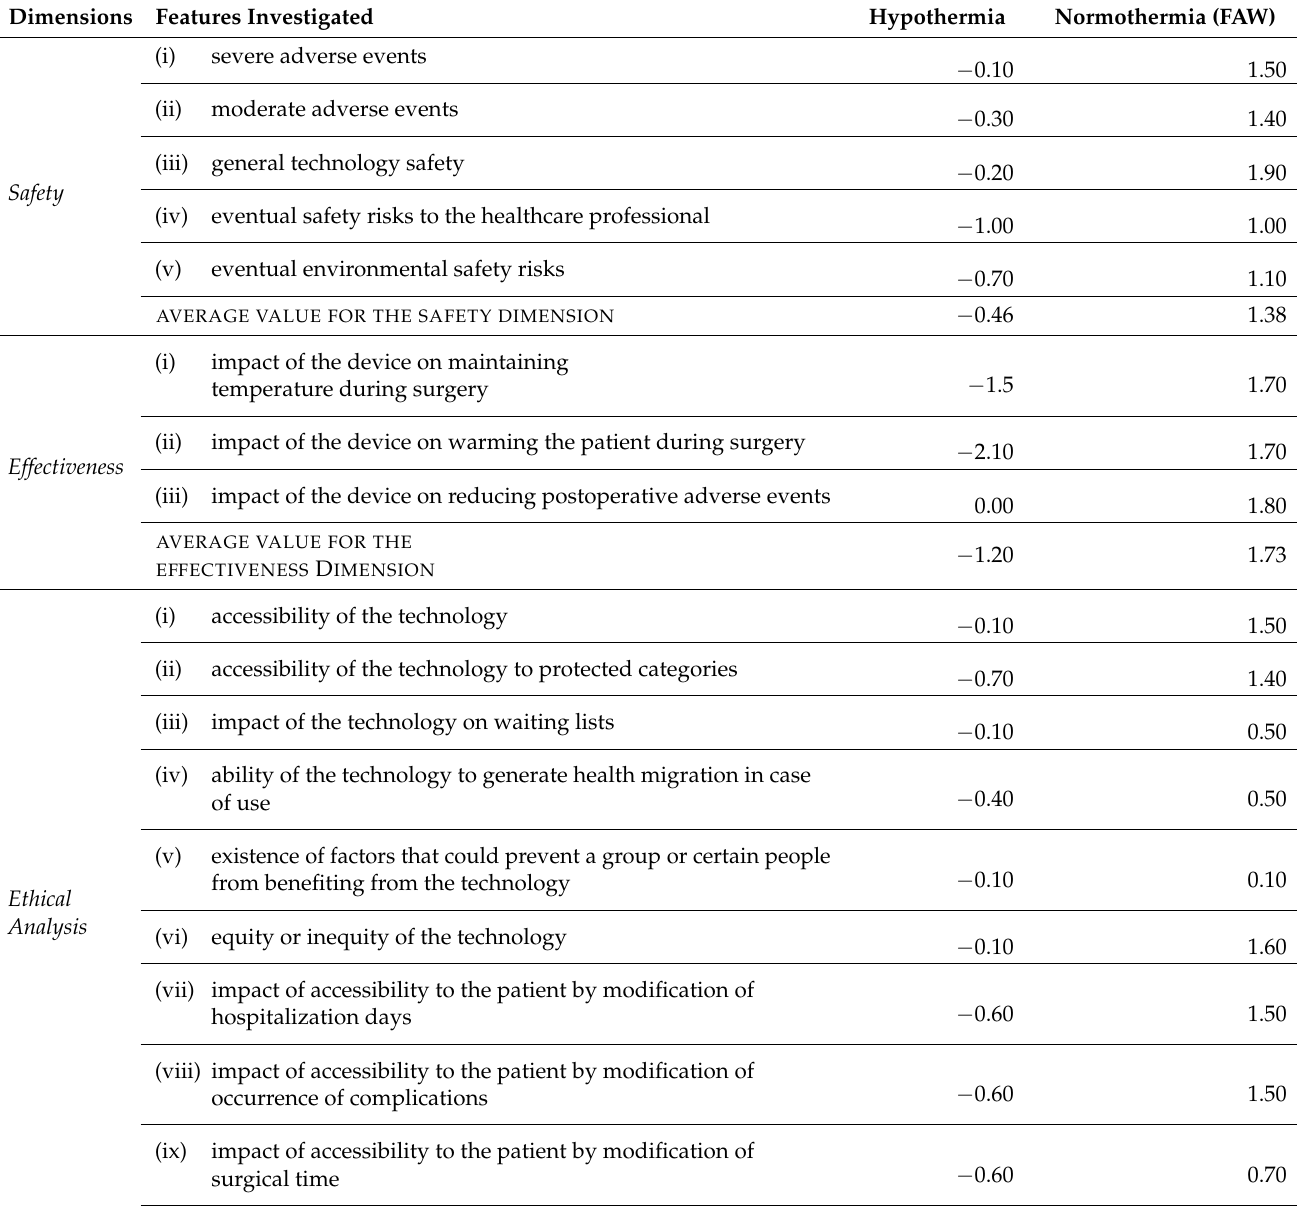
Table 7. Results of qualitative